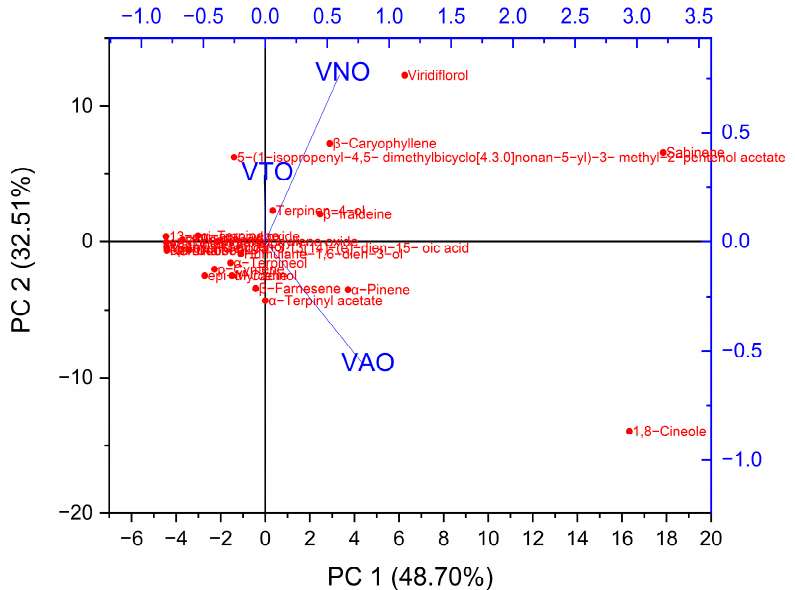
Figure 2. Principal Component Analysis of tested essential oil’s chemical constituents.